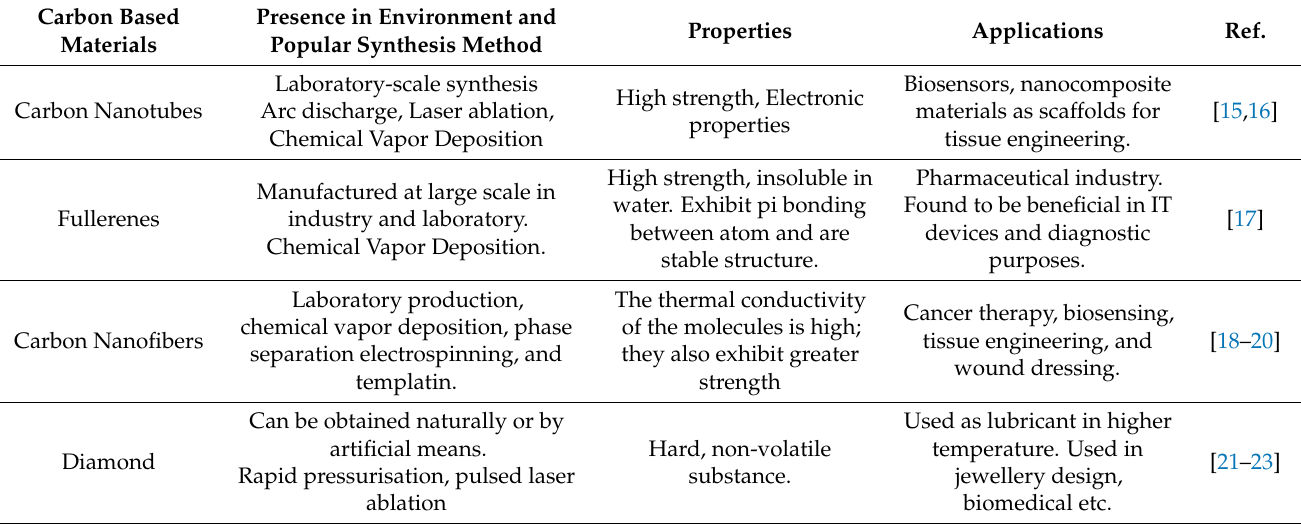
Figure 1. Various nanoforms of carbon allotropes with examples for 0D, 1D, 2D, and 3D carbon nanostructures. Table 1. Various forms of carbons and their commercial and laboratory applications